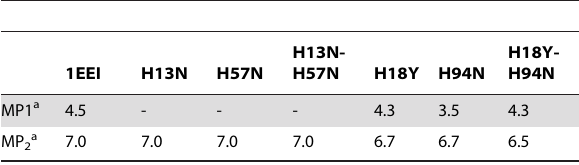
Table 2. Mid-point pH values determined by SDA for CtxB 5 wild-type and histidine